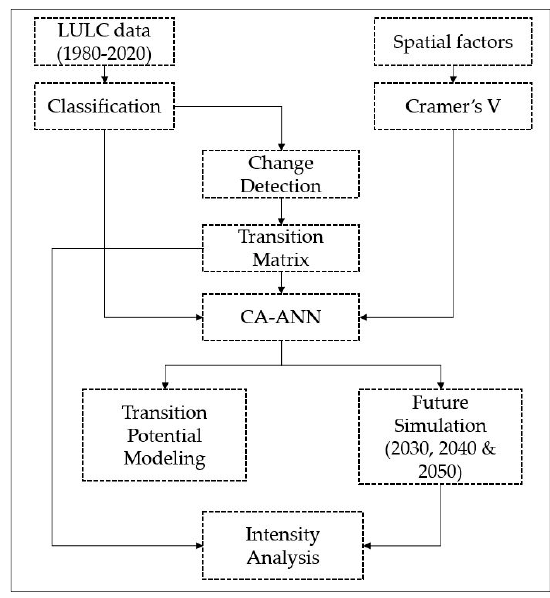
Figure 2. Methodological Workflow Chart.